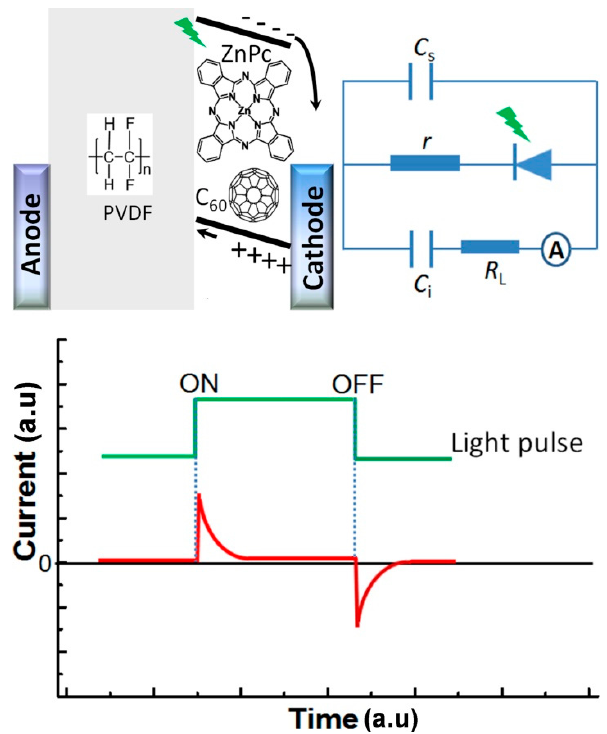
Figure 2. Photocurrent transients from MISM devices. The insets are the schematic views of the double-layer model and related molecular formulae, as well as the equivalent circuit.